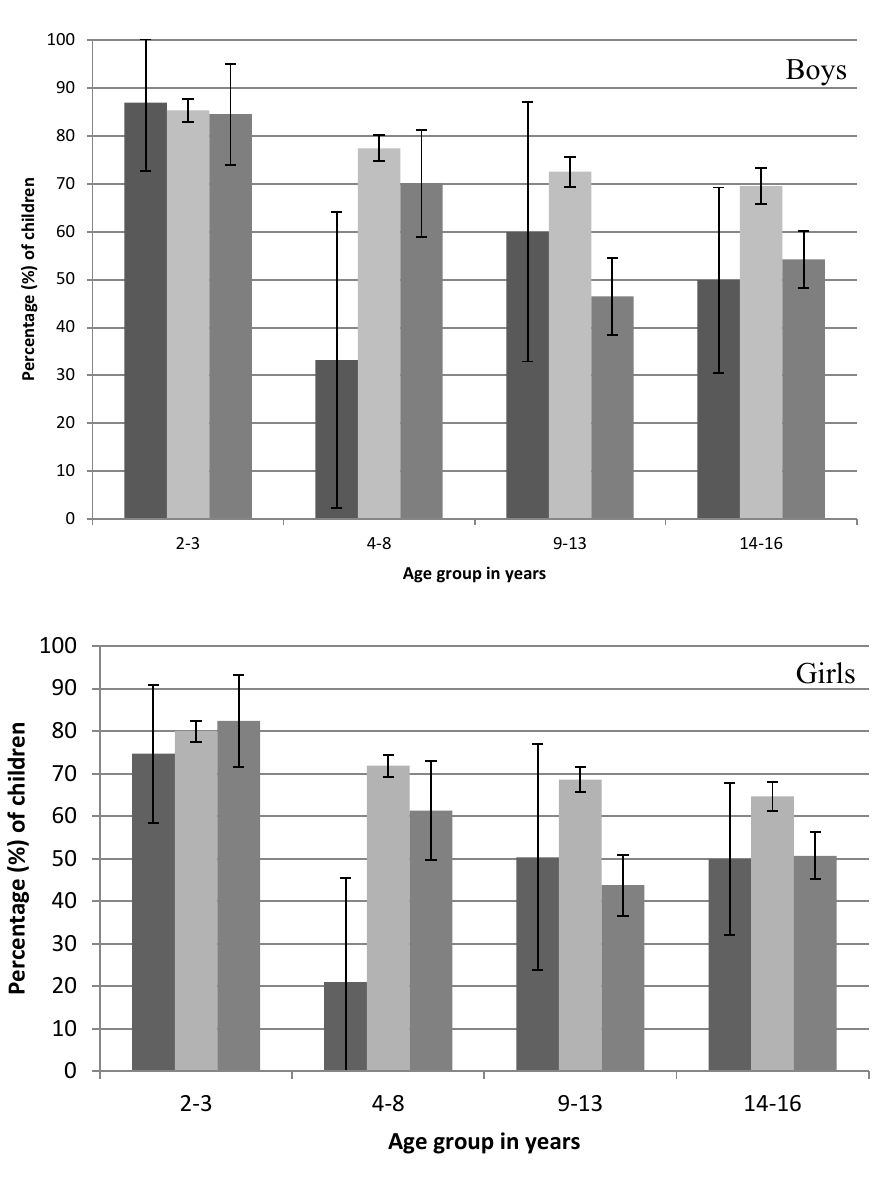
Figure 2. Percentage of children (±95% CI) where the first occasion of eating includes a dairy food by the start time of consumption ( before 6 a.m., 6 a.m. to 9 a.m., after 9 a.m.) on the day surveyed from the 2007 Australian National Children’s Nutrition and Physical Activity Survey (Computer Assisted Personal Interview